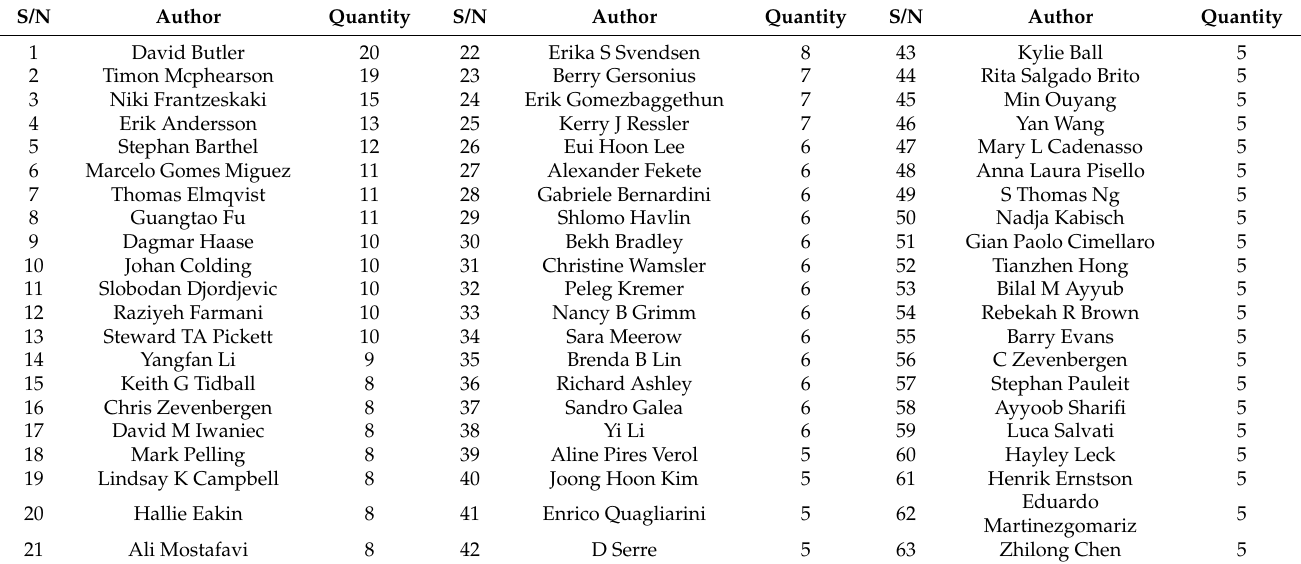
Table 2. Statistics on the number of articles published by core authors of RC